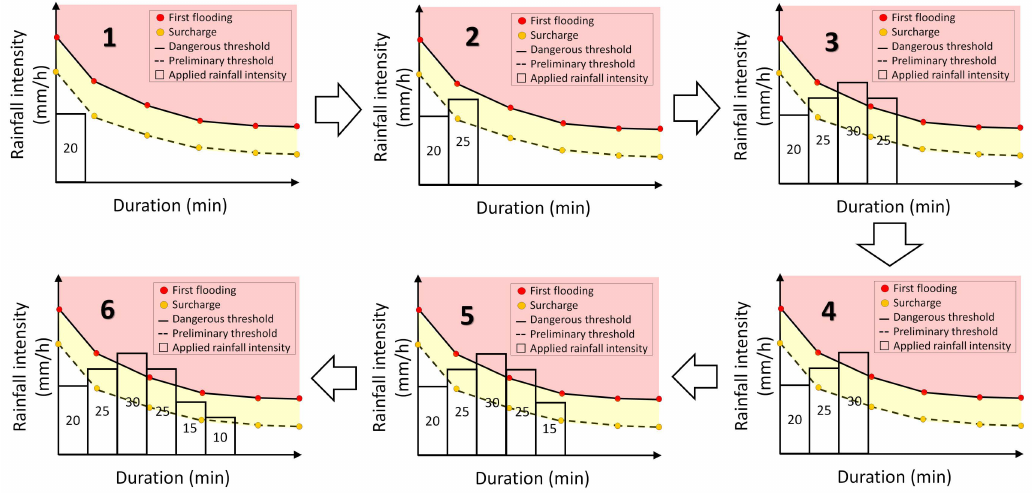
Figure 3. Application process of an advanced flood forecasting